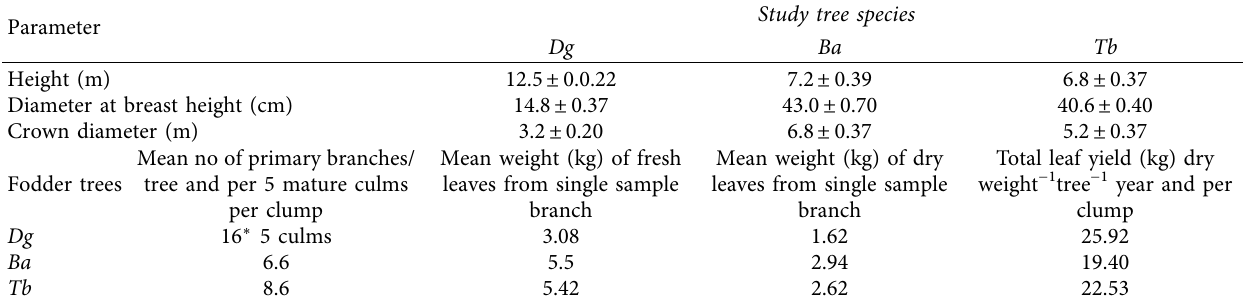
Table 1: Sample trees dendrometric parameters and estimated fodder biomass dry